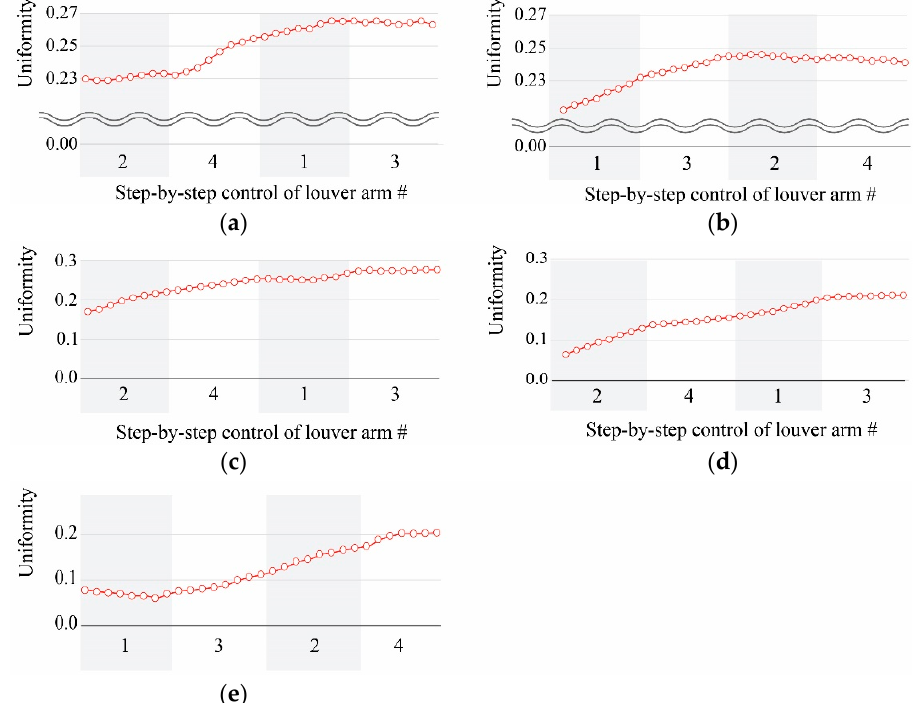
Figure 11. Uniformity by time during the winter according to operating Case 5. ( a ) From 10:00 to